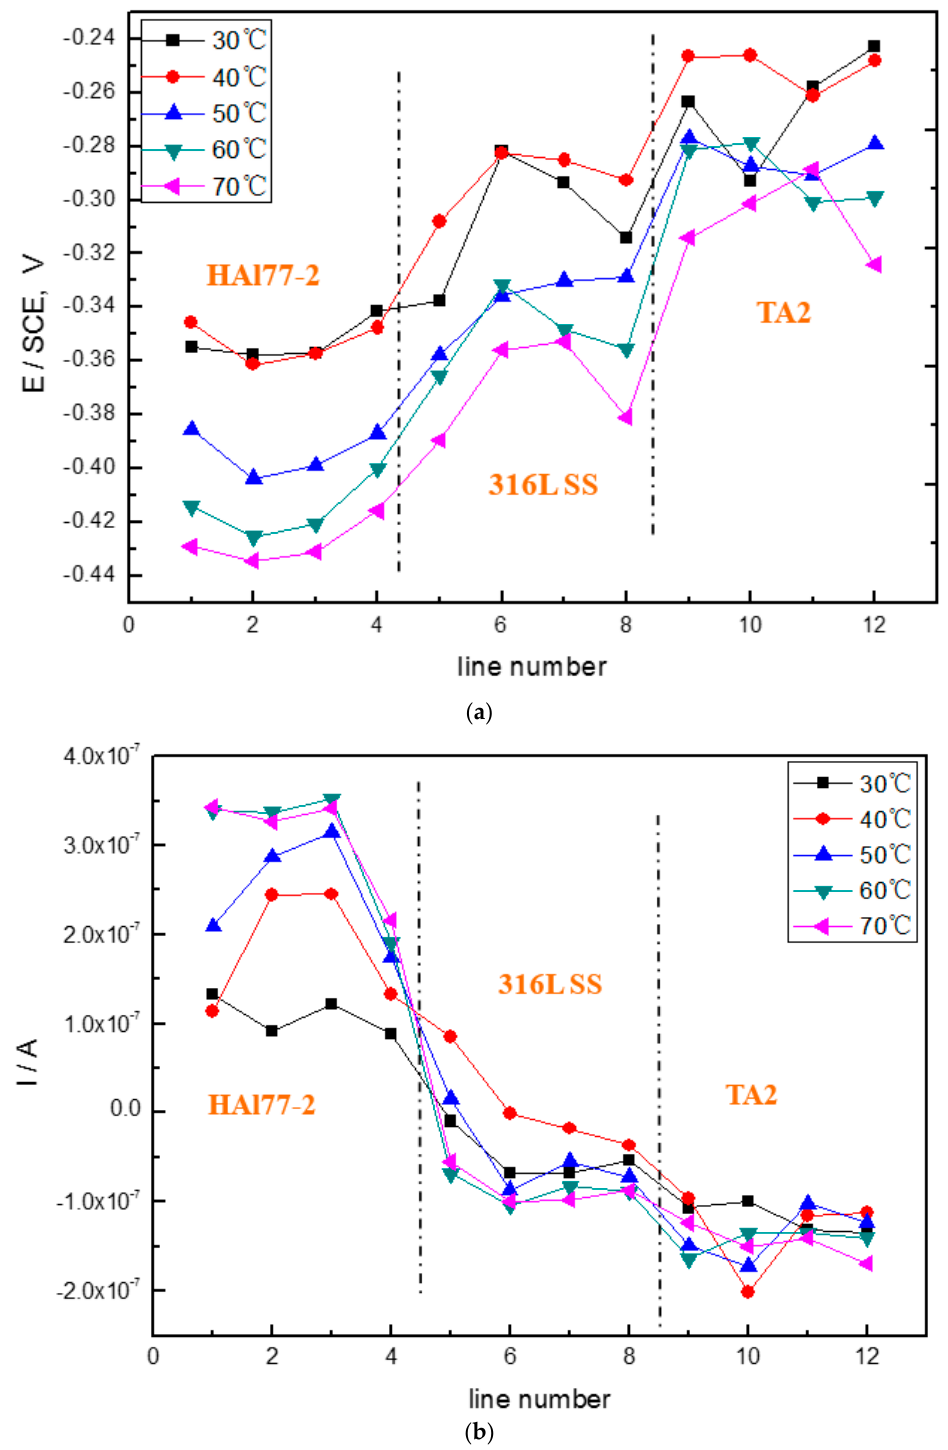
Figure 6. ( a ) Average potential; and ( b ) current–density distributions of each WBE1 microelectrode line after being short-circuited for 12 h in artificial seawater at different temperatures.